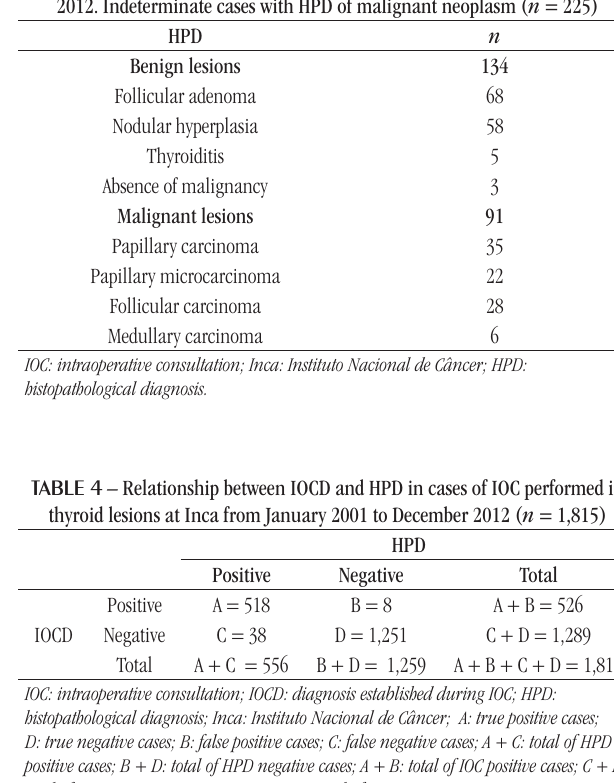
taBLE 3 – IOC of thyroid lesions at Inca from January 2001 to December 2012. Indeterminate cases with HPD of malignant neoplasm ( n = 225)